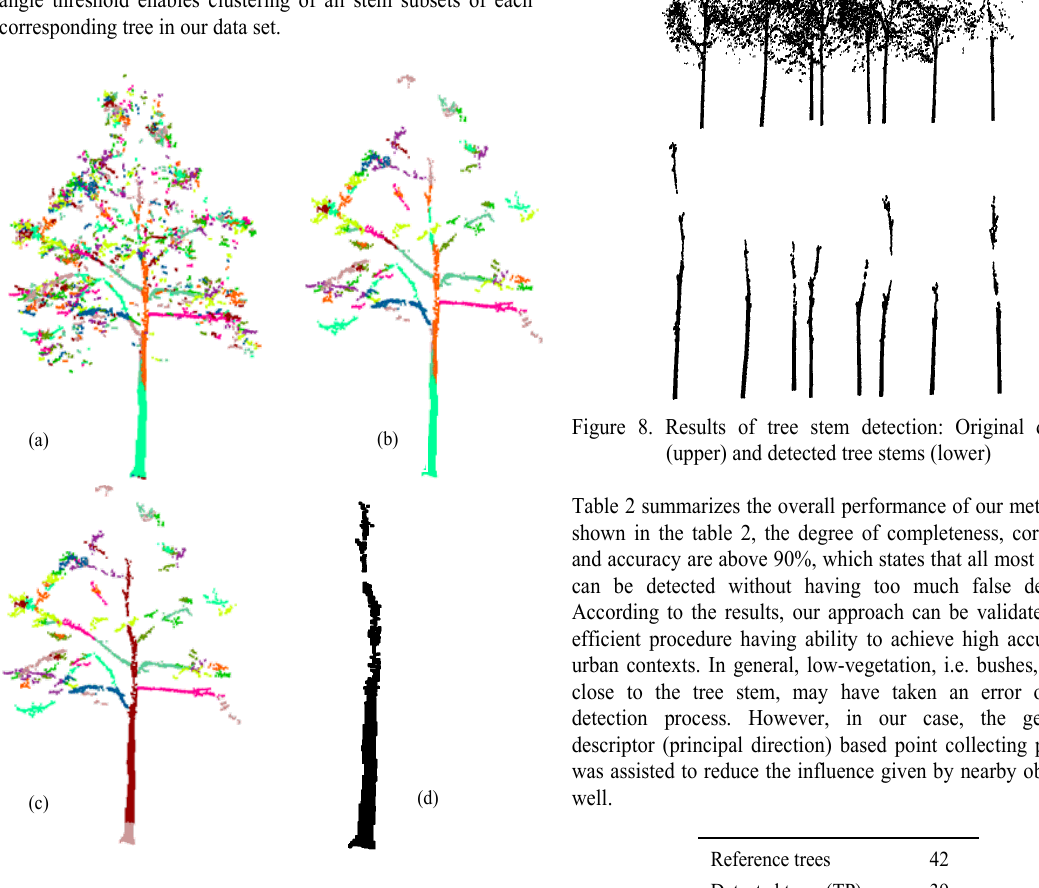
Figure 7. Analysis of a selected tree; (a) created subsets, (b) selected flat and elongated subsets from stem and branches, (c) final result of the stem detection (dark brown-stem, brown-base) and (d) detected stem